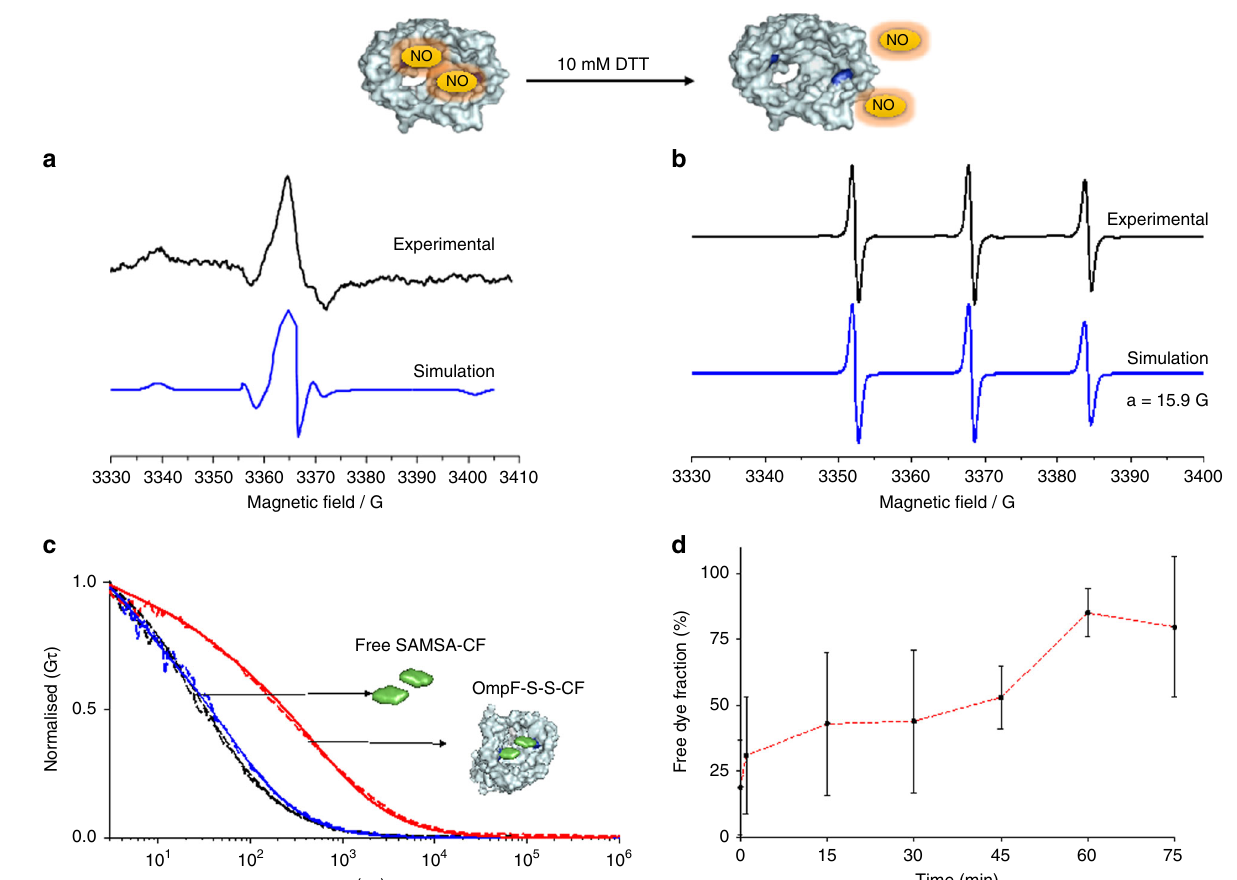
Fig. 2 Characterisation of stimuli-responsive OmpF Panel. a EPR spectra of bis-(2,2,5,5-tetramethyl-3-imidazoline-1-oxyl-4-yl) disulphide-labelled OmpF-M experimental (black) and simulated (blue) and b bis-(2,2,5,5-tetramethyl-3-imidazoline-1-oxyl-4-yl) disulphide-labelled OmpF-M in 1% OG incubated with 10 mM DTT experimental (black) and simulated (blue). c Normalised FCS autocorrelation curves for SAMSA-CF in PBS (black), SAMSA-CF in 1% OG (blue) and OmpF-S-S-CF in 1% OG (Red). Dotted line — experimental autocorrelation curves, full line — fi t. d SAMSA-CF release kinetics from OmpF-M in 30 mM GSH, 1% OG, as measured by FCS and analysed with a two-component fi t. Error bars show standard deviations